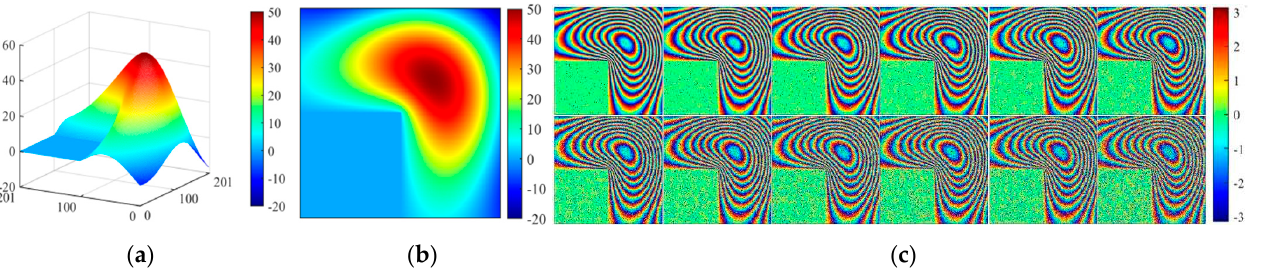
Figure 6. More simulated data for robustness analysis (unit is rad): ( a ) three-dimensional display of simulated terrain phase; ( b ) the simulated unwrapped phase; ( c ) noisy interferograms obtained by adding noise according to coherence values from 0.90 to 0.65.